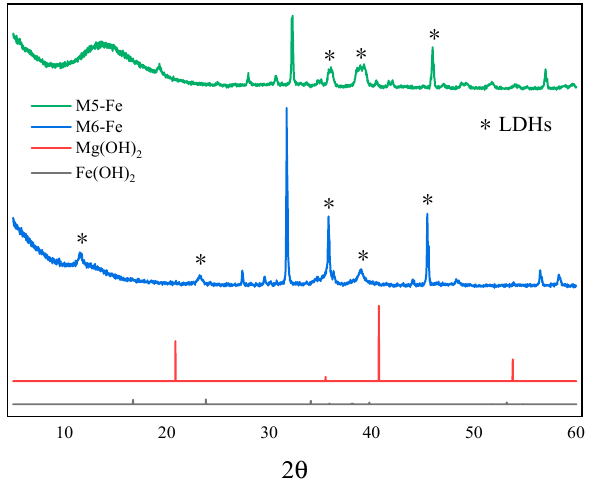
Figure 10. X-ray diffraction results for some Fe-doped MMH samples. Figure 10 . X-ray diffraction results for some Fe-doped MMH samples.